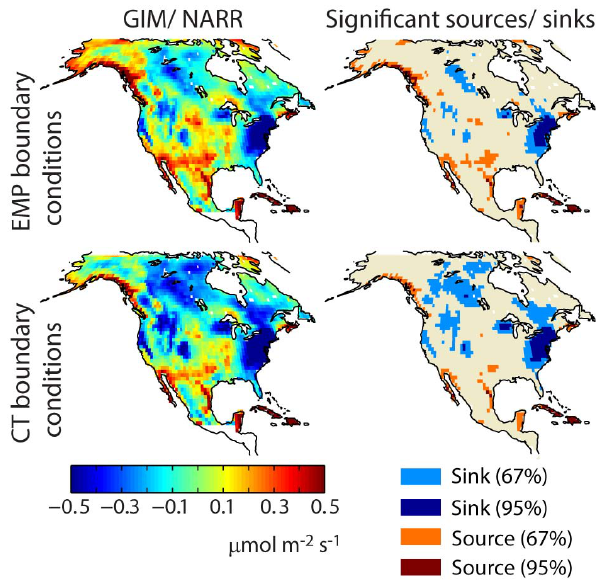
Fig. 6. Annually-averaged grid-scale biospheric fluxes from the GIM NARR inversions using the EMP and CT boundary condi- tions. Also shown are significant sources and sinks (at 67% and 95% confidence levels) for each